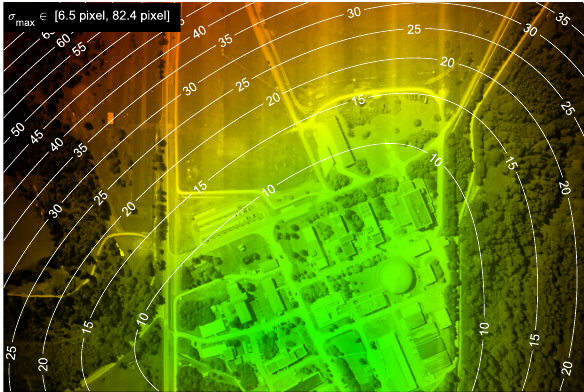
Figure 5. Contour plot depicting Helmert’s point error. The values have been mapped to the hue of the image using the color code of traffic